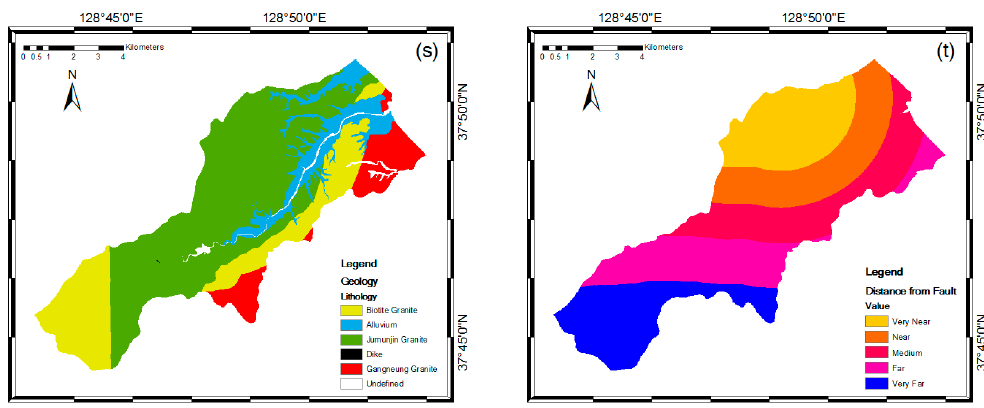
Figure 4. Spatial databases of the landslide causative factors; slope ( a ), aspect ( b ), maximum curvature ( c ), profile curvature ( d ), convexity ( e ), texture ( f ), mid-slope position (MSP) ( g ), topographic position index (TPI) ( h ), terrain ruggedness index (TRI) ( i ), flow accumulation ( j ), stream power index (SPI) ( k ), topographic wetness index (TWI) ( l ), land cover ( m ), soil ( n ), forest type ( o ), forest age ( p ), forest density ( q ), forest diameter ( r ), geology ( s ), distance from fault ( t ).